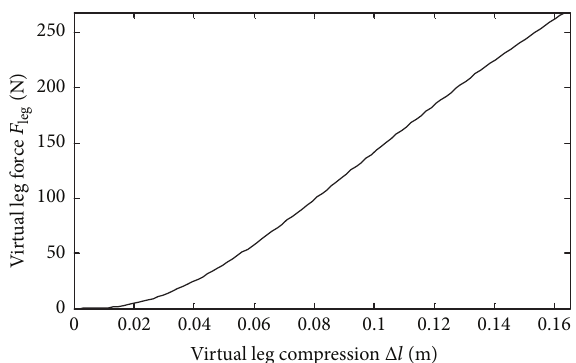
Figure 9: Virtual leg force-compression relationships of KOLT quadruped